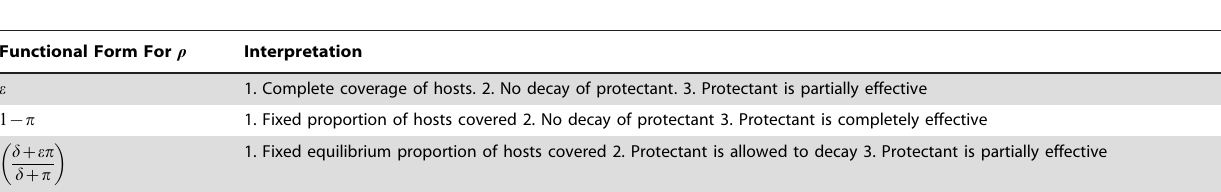
Table 1. Expressions for r . Potential expressions for r , the reduction in infection rate in the implicit model, and their interpretations in terms of assumptions made about the behaviour of the